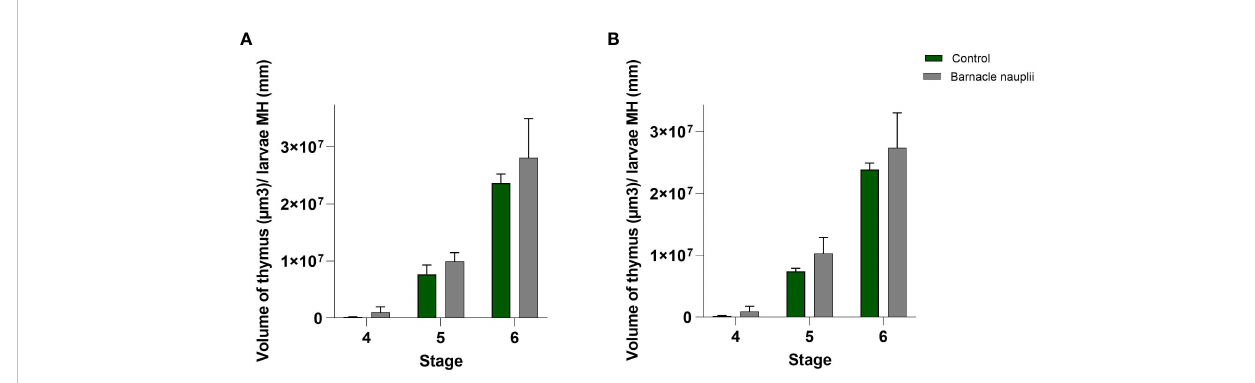
FIGURE 10 Volumetric analysis of the wrasse larvae thymus (n=3). (A) Left-side thymus and (B) Right-side thymus. MH: Myotome height. The barnacle nauplii diet triggered larger volume of the thymus (glm; p